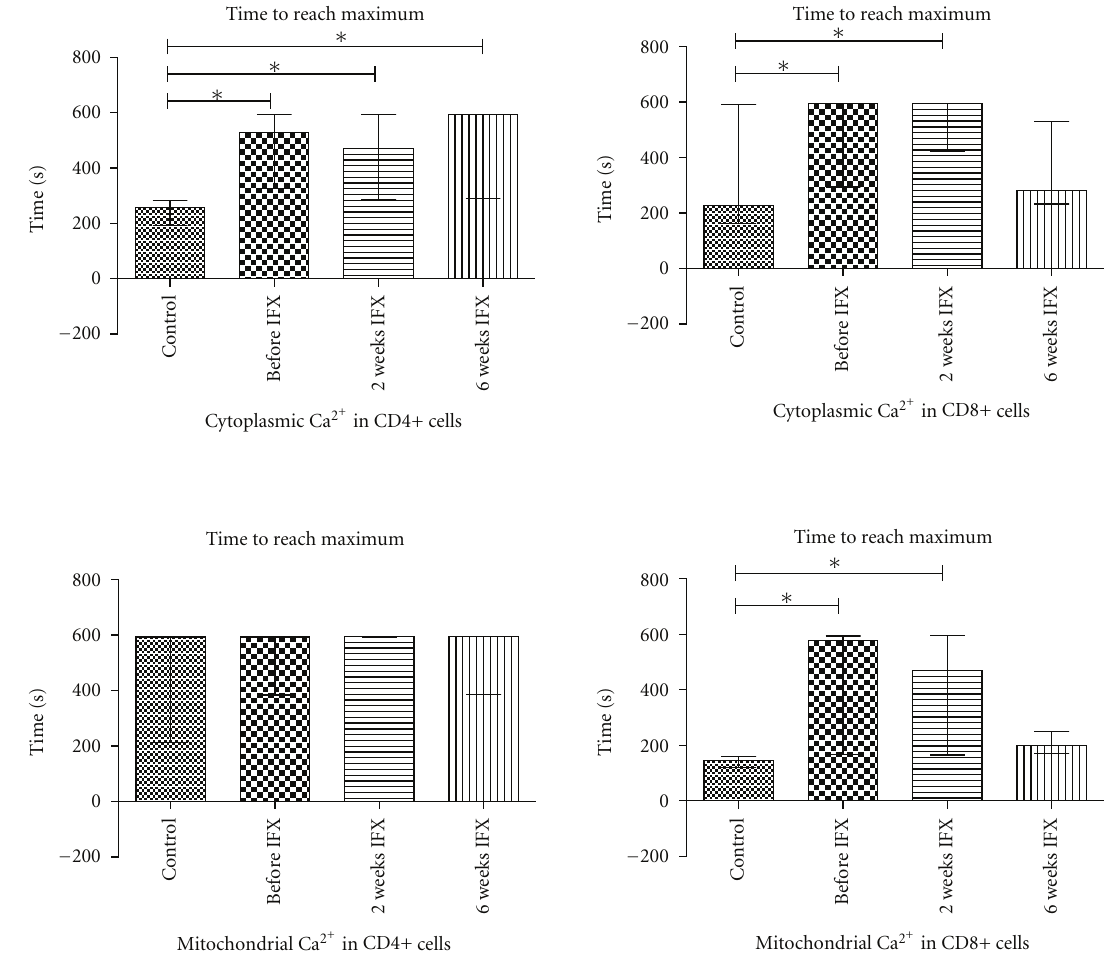
Figure 2: Time to reach maximum in cytoplasmic and mitochondrial Ca 2+ levels in CD4+ and CD8+ cells following activation in healthy controls ( n = 9) and ankylosing spondylitis patients before infliximab (IFX) therapy ( n = 13) then 2 and 6 weeks after initiation of IFX ( n = 11 and 8, resp.). ∗ P < 0 .